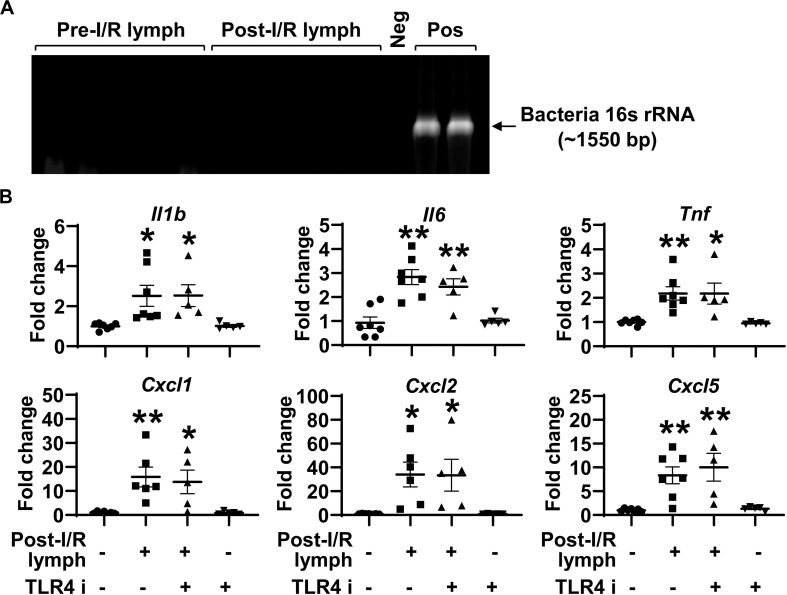
Toll like receptor (TLR) 4 does not mediate post-I/R lymph-induced neutrophil activation. (A) Lymph samples, regardless of I/R status, are free of bacteria 16s rRNA. Neg, sterile water. Pos, pseudomonas aeruginosa. n = 5/group. (B) Blocking TLR4 does not affect post-I/R lymph-induced neutrophil upregulation of cytokines and chemokines. TLR4 i, TLR4 inhibitor (1 μM). n = 5–7/group. *p < 0.05, **p < 0.01 vs. control. One-way ANOVA was used.